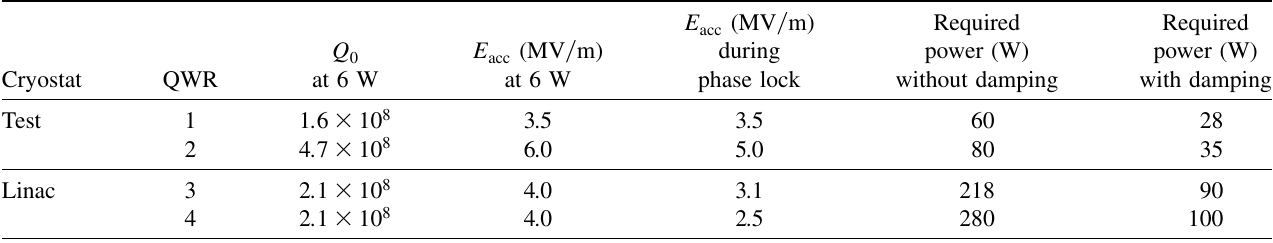
TABLE II. A comparison of the power requirement to obtain the phase and amplitude lock of the resonators without and with damping mechanism in test and linac